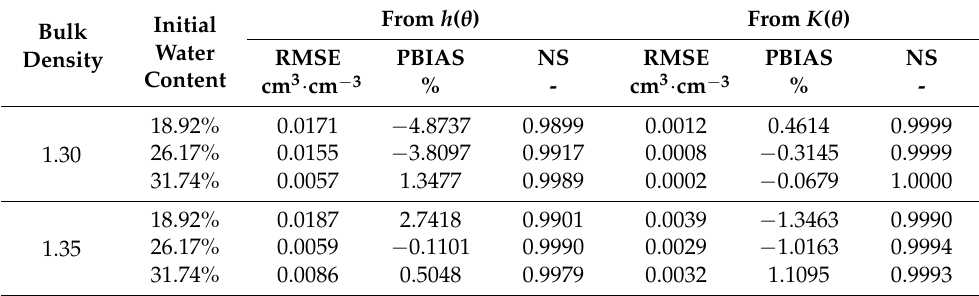
Table 10. Error analyses for three initial water content